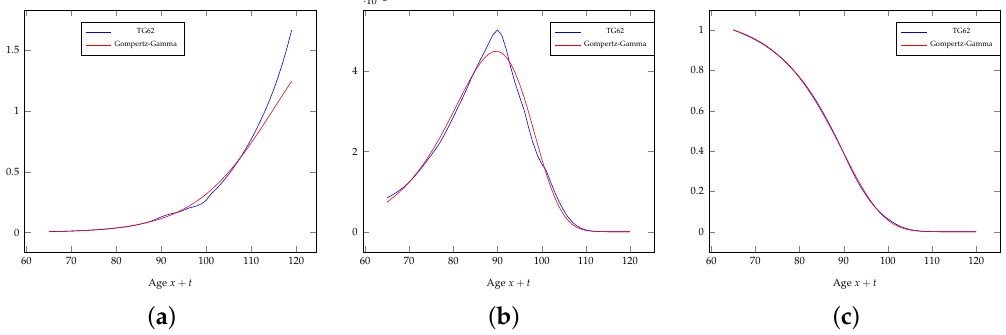
Figure 2. Comparison between the life table TG62 and the Gompertz-Gamma model for the general population (force of mortality, probability density function of T 65 , survival function). ( a ) Force of mortality µ x ; ( b ) Probability density function f 65 ( t ) ; ( c ) Survival function S ( x )